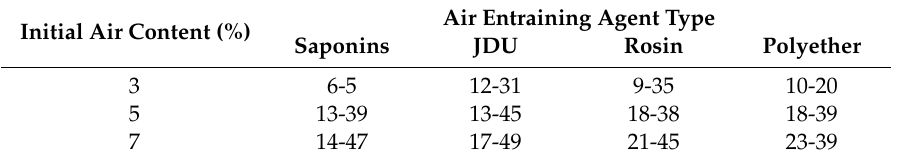
Table 4. The decrease of air content under low atmospheric pressure (LAP) (%).